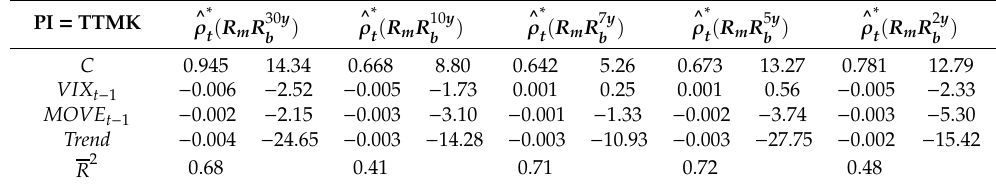
Table 3. Estimates of aggregate and categorical EPU, FPU, and MPU and on stock (TTMK)–bond return correlations.